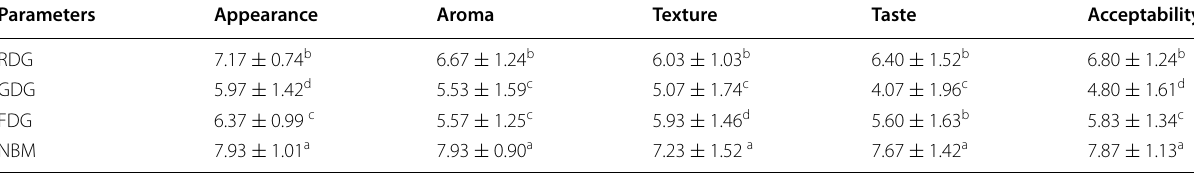
RDG Raw maize, defatted groundnut and ginger in ratio 76.7:20.8:2.5 GDG Germinated maize, defatted groundnut and ginger in ratio 74.4:23.1:2.5 FDG Fermented maize, defatted groundnut and ginger in ratio 72.6:24.9:2.5 NBM Nutribom (a commercial maize-based complementary food) a, b, c, d Means ( SEM) with different alphabetical superscripts in the same row are significantly different at P < 0.05 ±